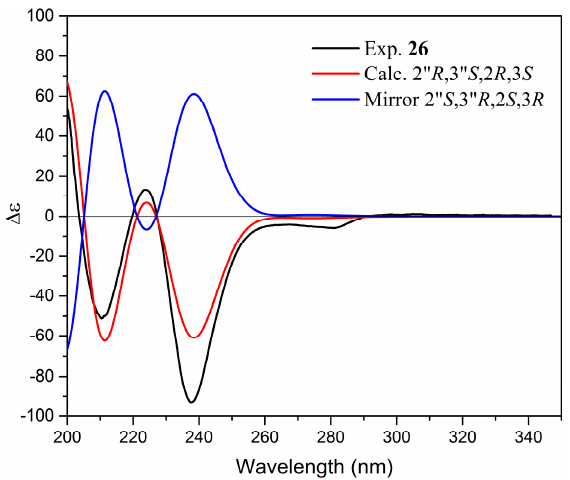
Figure 7. Comparison of experimental and calculated ECD spectra of 26 .